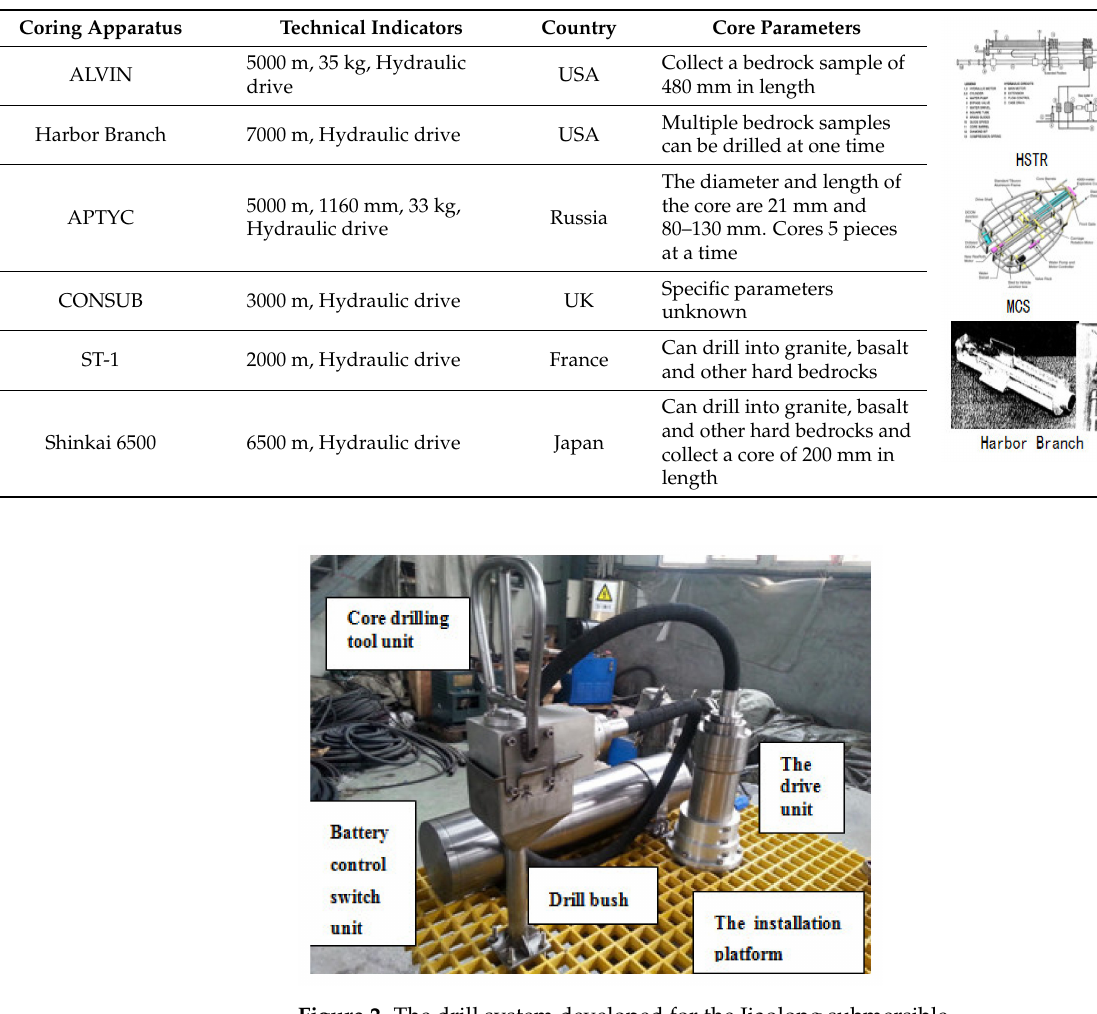
Figure 2. The drill system developed for the Jiaolong